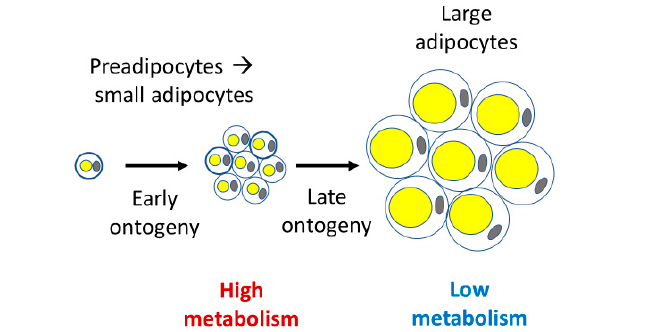
Figure 6. Schematic representation of the two-phase ontogeny of adipocytes (fat cells). Early in ontogeny, many small fat cells are produced, which according to cell surface area theory should have relatively high mass-specific metabolic rates (see Section 2.1.1). Later in ontogeny, these small fat cells enlarge as they become filled with lipid deposits, which should have a relatively low mass-specific metabolic rate due to their reduced surface area per volume and the accumulation of metabolically inert fat deposits (see Section 2.3.3). Hypothetically, the development of many large adipocytes with metabolically inert fat deposits should help cause a lower whole-body mass-specific metabolic rate, and thus contribute to a hypometric ontogenetic body-mass scaling of metabolic rate (slope b < 1).